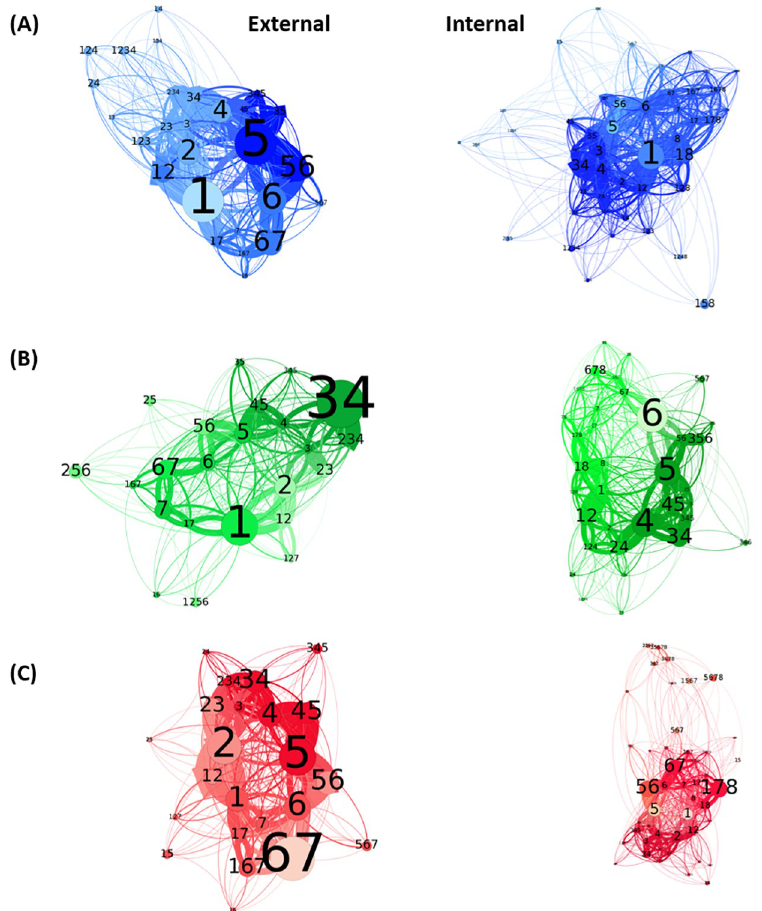
Fig 5. Network graph of lipid movements around μ OR. Network graph obtained using Gephi as determined from the three 15 μ s CG MD runs at P = 1.01325 bar and T = 310 K of (A) POPC, (B) DPPC, and (C) POPE interacting with μ OR for the external and internal membrane layers. Each circle represents a site of μ OR, according to helix label. As an example, 167 stands for helices H1, H6, and H7. The more often a site is visited by lipids, the larger the circle. In the same way, a connection between two nodes is thicker when the lipid transfer frequency between two protein sites is higher. In each network, the node color shade is a function of the clustering results, as described in Materials and